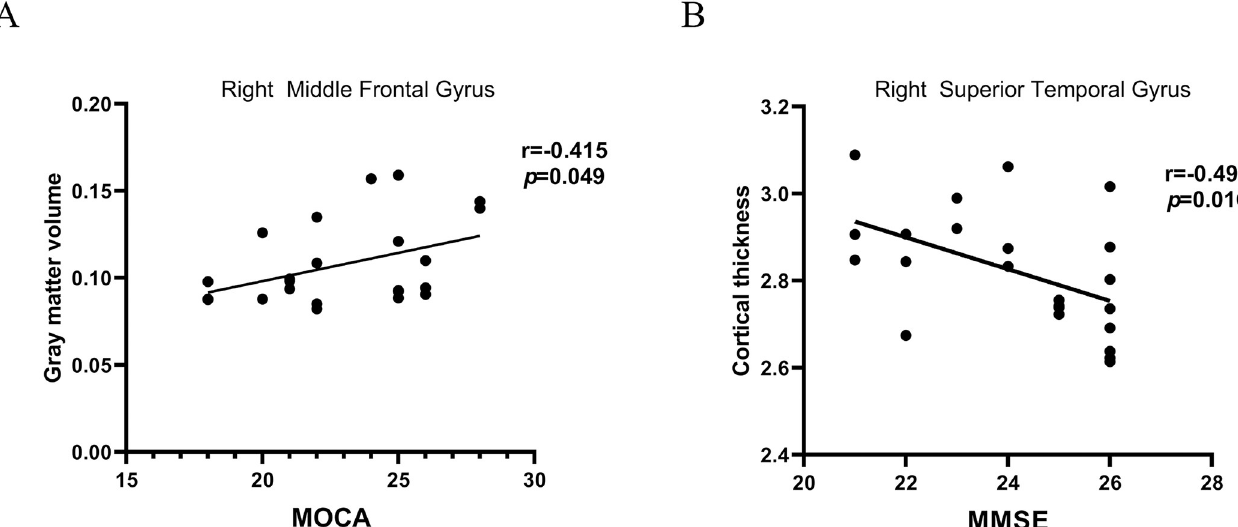
Fig 3. Receiver operating curve (ROC) analyses of the brain structure measurements in the gray matter volume (left column) and cortical thickness (right column) for differentiating PD with MCI from PD patients without MCI (A) and healthy controls (B). RMFG, right middle frontal gyrus; RIFG, right inferior frontal gyrus; RPUT, right putamen; LPUT, left putamen; RINS, right insula; RCER8, right cerebellum lobule VIII; LMTG, left middle temporal gyrus; RSTG, right superior temporal gyrus; LCUN, left cuneus; LPCUN, left precuneus. AUC, area under the ROC curve.